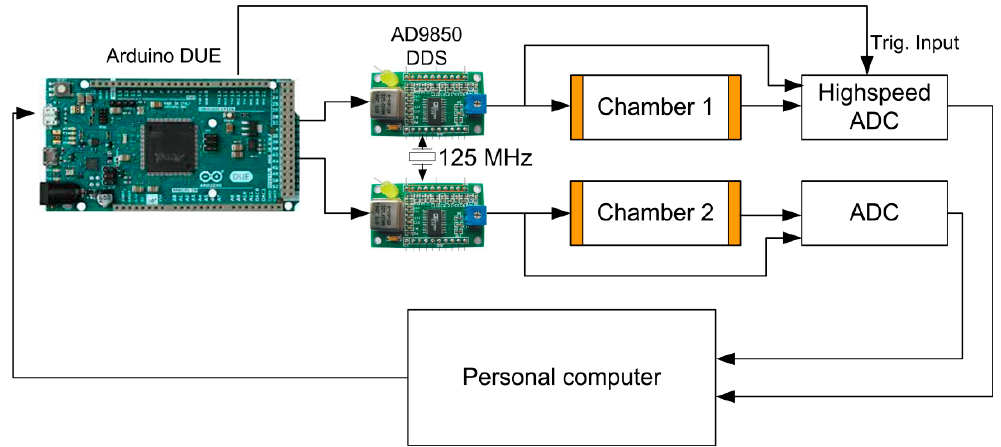
Figure 1. Block diagram of the setup containing a fixed-length ultrasonic spectrometer.